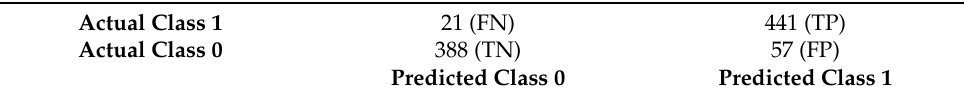
Table 1. Confusion matrix on test dataset of the convolutional neural network model trained for differentiation between Class 0 and Class 1 type objects (See Figure 2). n = 907; FN = False Negative; TP = True Positive; TN = True Negative; FP = False